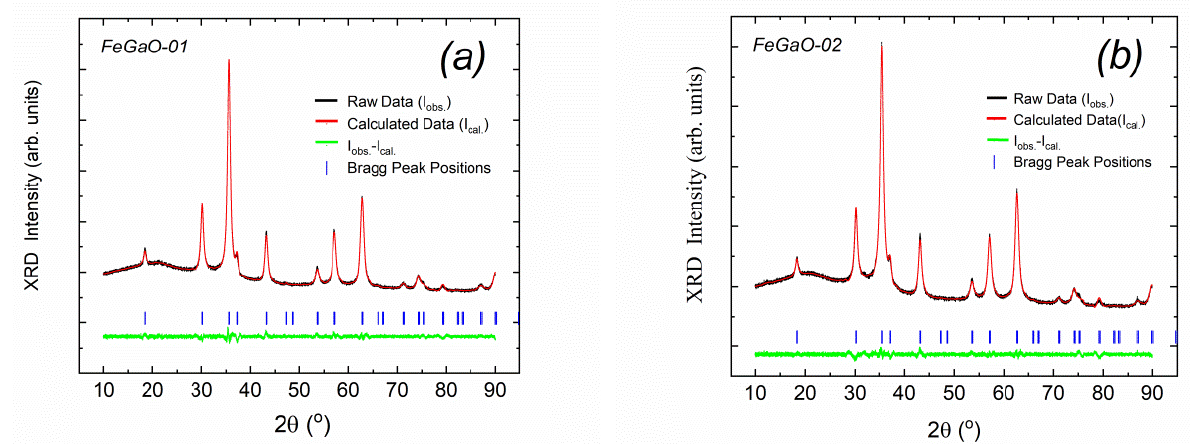
Figure 3. Rietveld refinements fits for the synthesized samples of ( a ) FeGaO-01 and ( b )